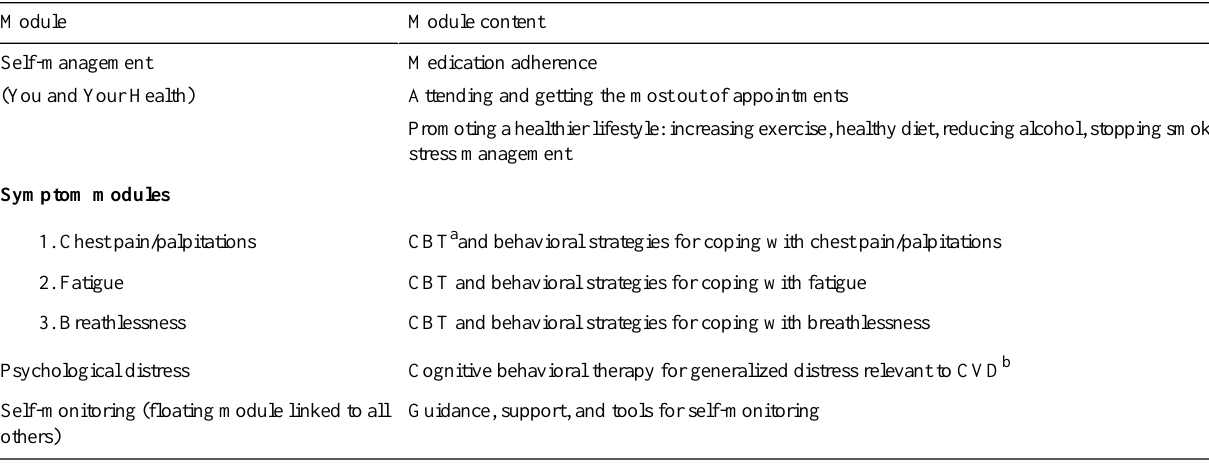
Table 1. Space from Heart Disease intervention